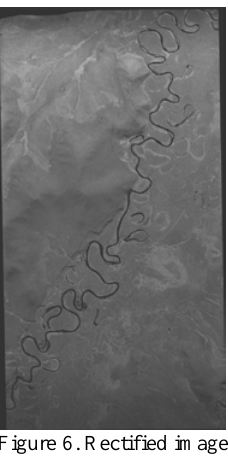
Figure 6. Rectified image